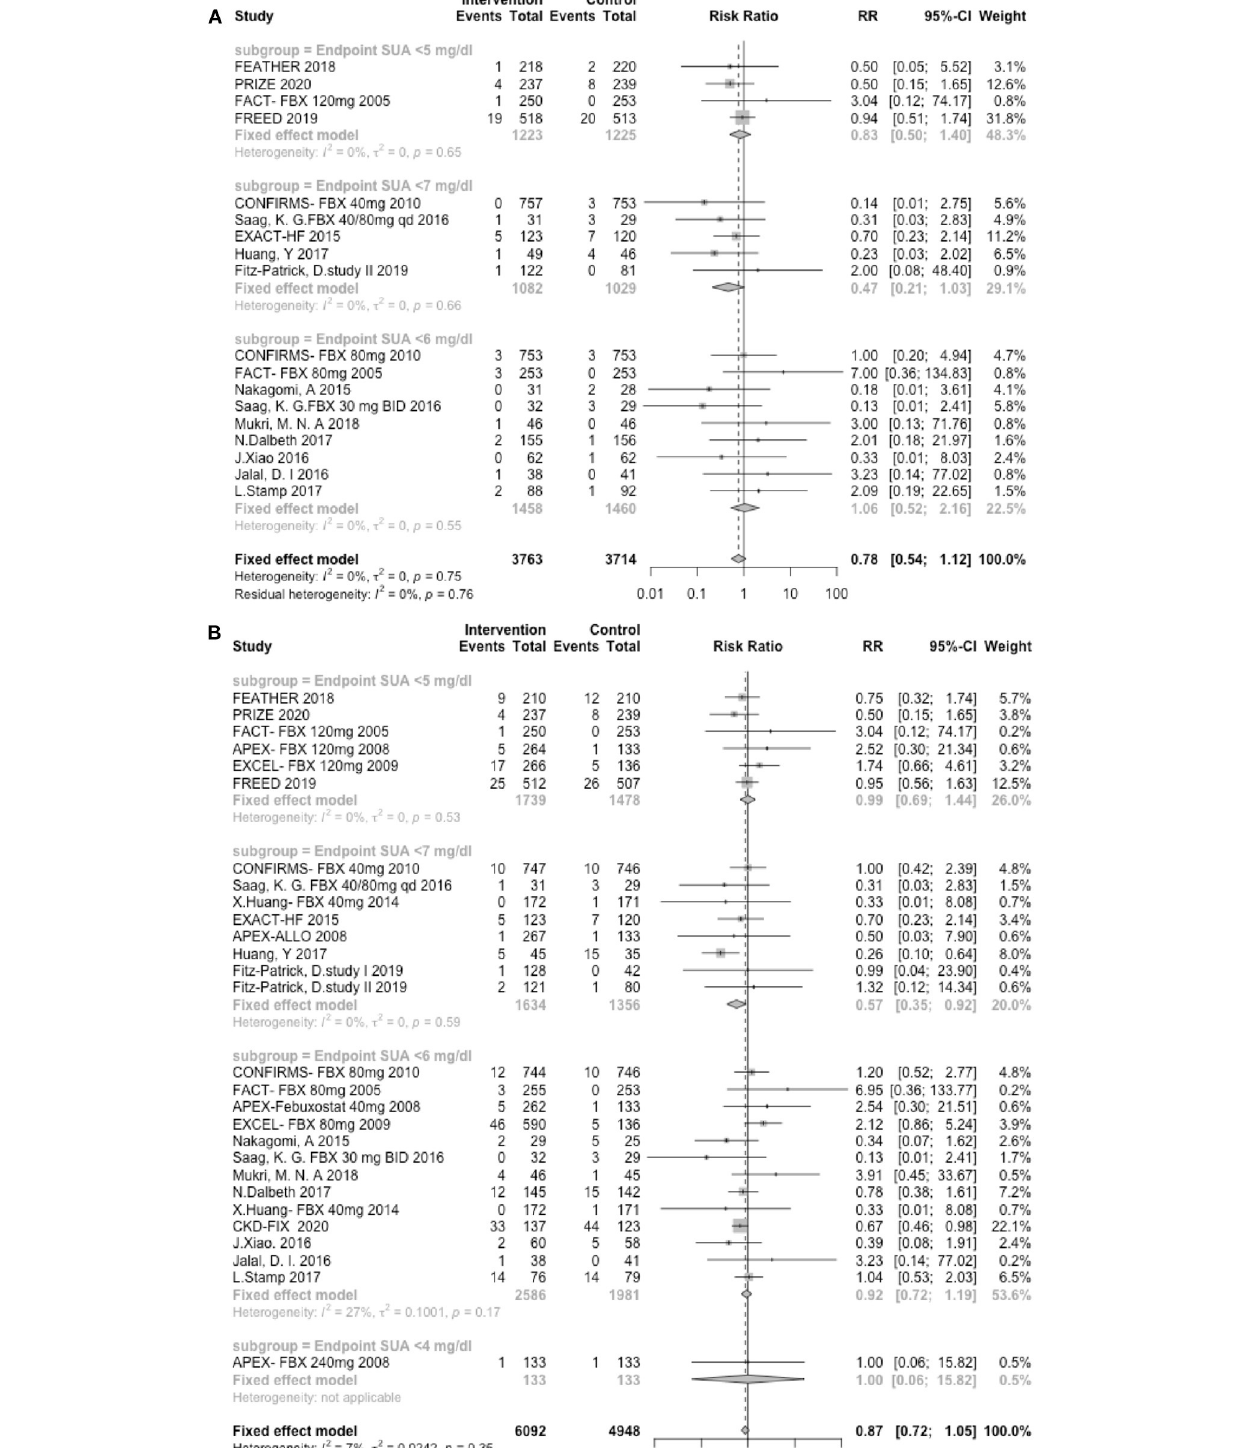
Frontiers in Cardiovascular Medicine |